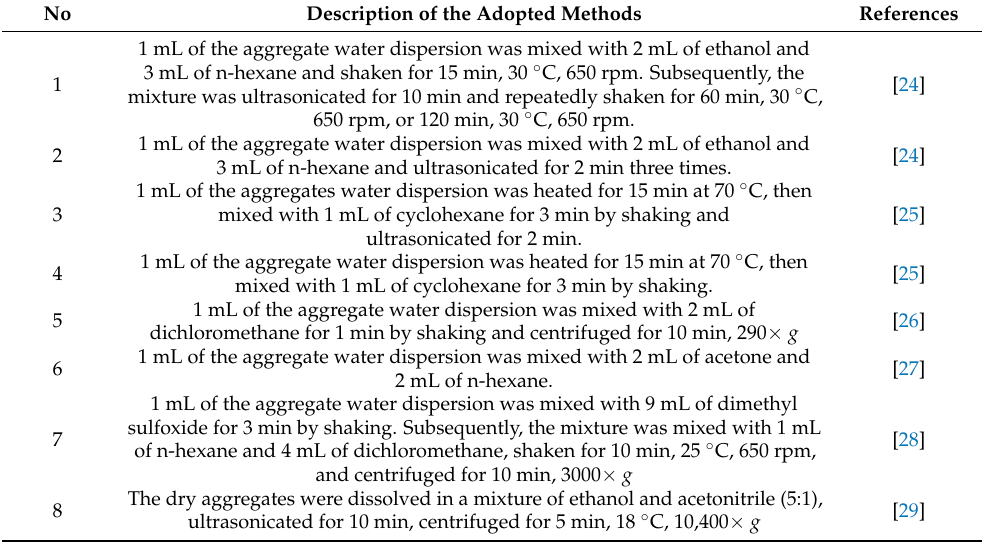
Table 1. Adopted methods of carotenoid extraction from the aggregates based on cyclodextrins. No Description of the Adopted